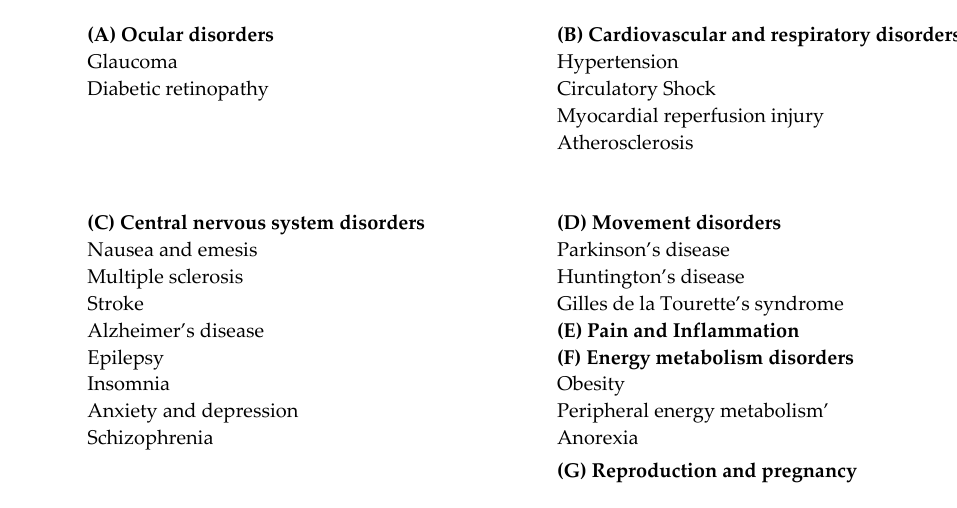
Figure 6. The functions and pharmacotherapy targets of the endocannabinoid system [150]. Figure modified with text, and annotation after adaptation of “Nervous System” from Servier Medical Art by Servier, licensed under a Creative Commons Attribution 3.0 Unported License [180] and reference [181] with permission.